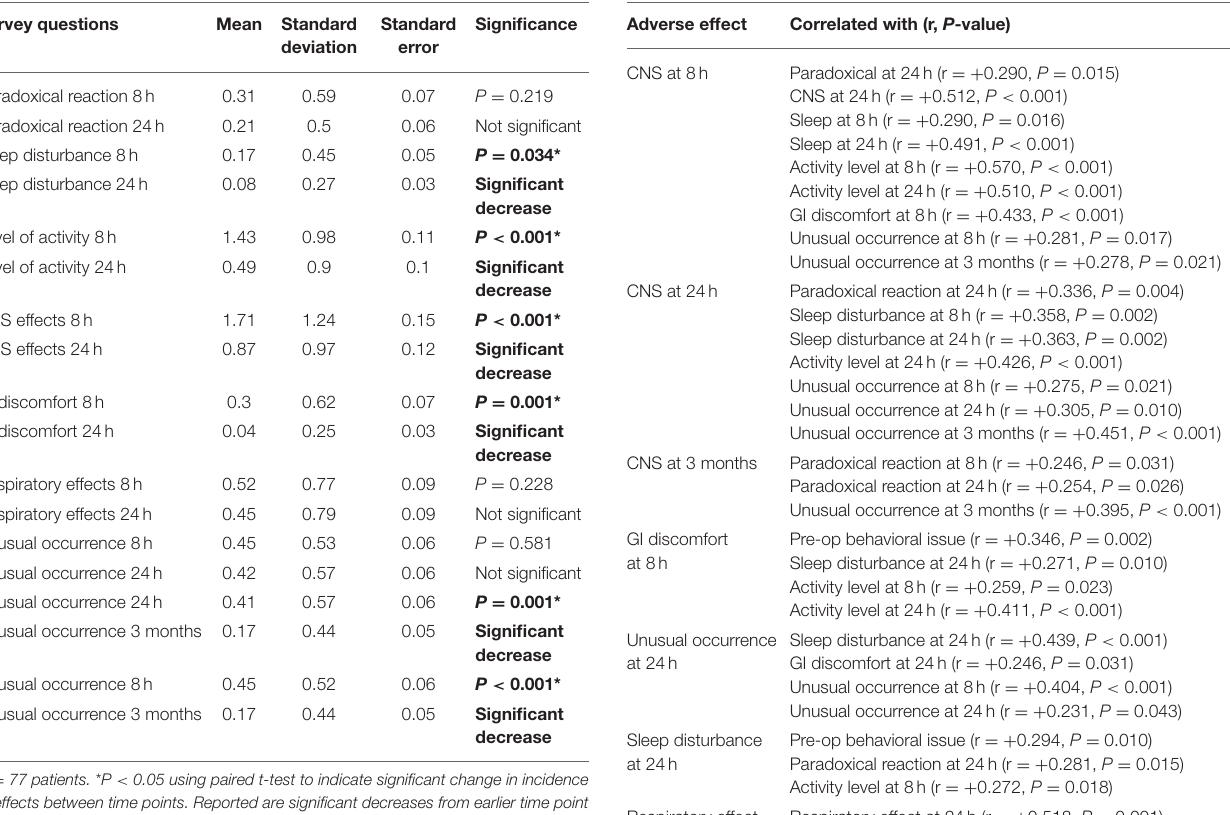
TABLE 3 | Paired t -test statistics for adverse behavioral effects over time. TABLE 4 | Correlation between adverse behavioral effect